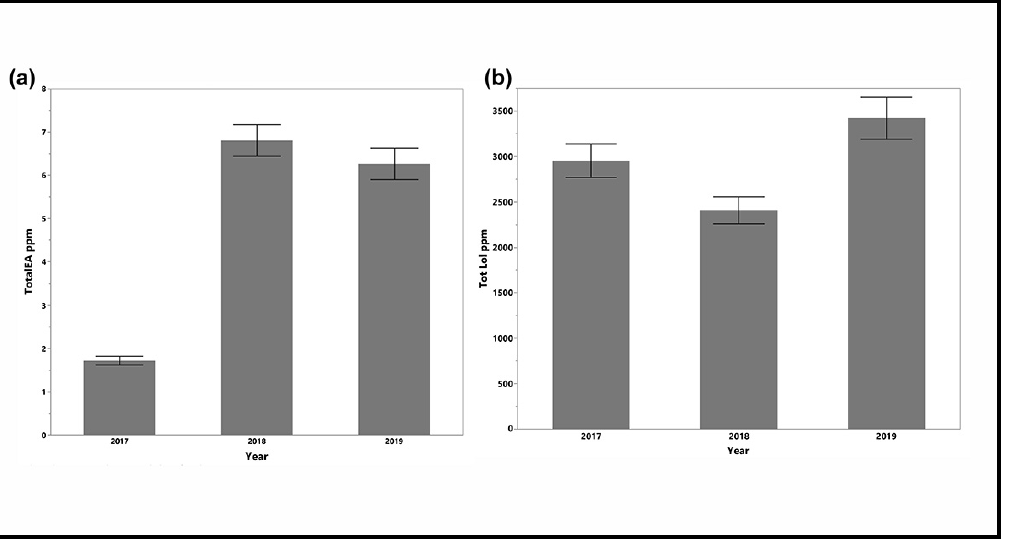
Figure 1. Levels of ( a ) ergot (Total EA) and ( b ) loline (Total lol) alkaloid accumulation across all clones for 2017, 2018 and 2019. Data are means +/ − 1 s.e.